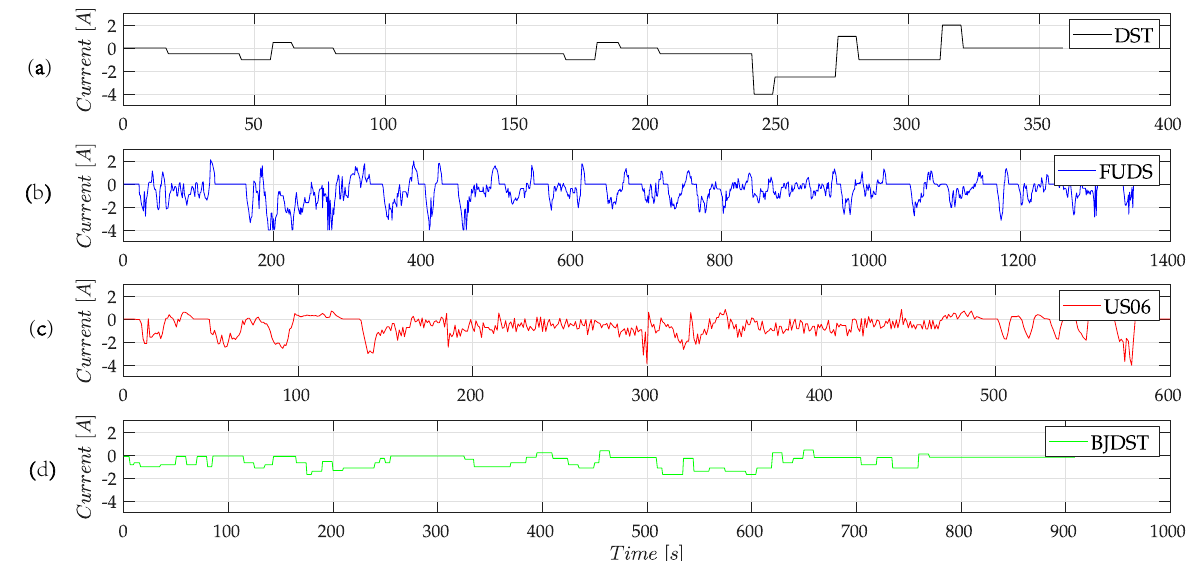
Figure 14. Dynamic test profile showing the applied current for the INR 18650-20R dataset: ( a ) Dynamic Stress Test, ( b )